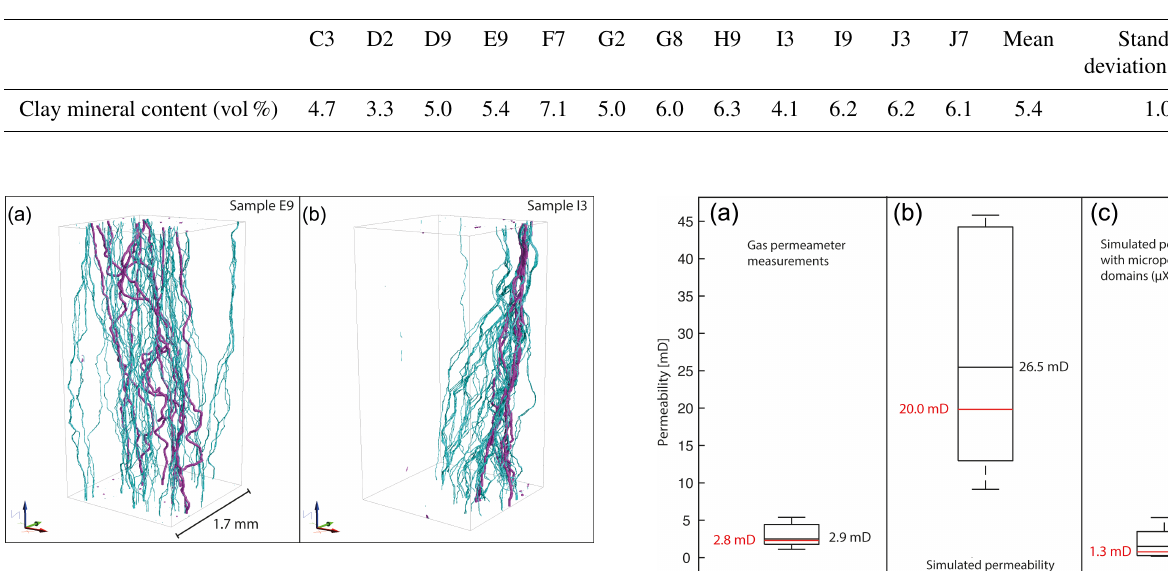
Figure 10. Comparison of percolation paths in two µXCT recon- structions of the 3D imaging data without microporous domain modelling. (a) Well distributed percolation paths in a µXCT recon- struction of mini plug sample E9 without microporous domain mod- elling. (b) Constricted percolation paths with flow impingement limited to a small region of the structure in mini plug sample I3 without microporous domain modelling. The 10 largest percolation paths are coloured in purple; the 100 largest percolation paths are coloured in cyan.